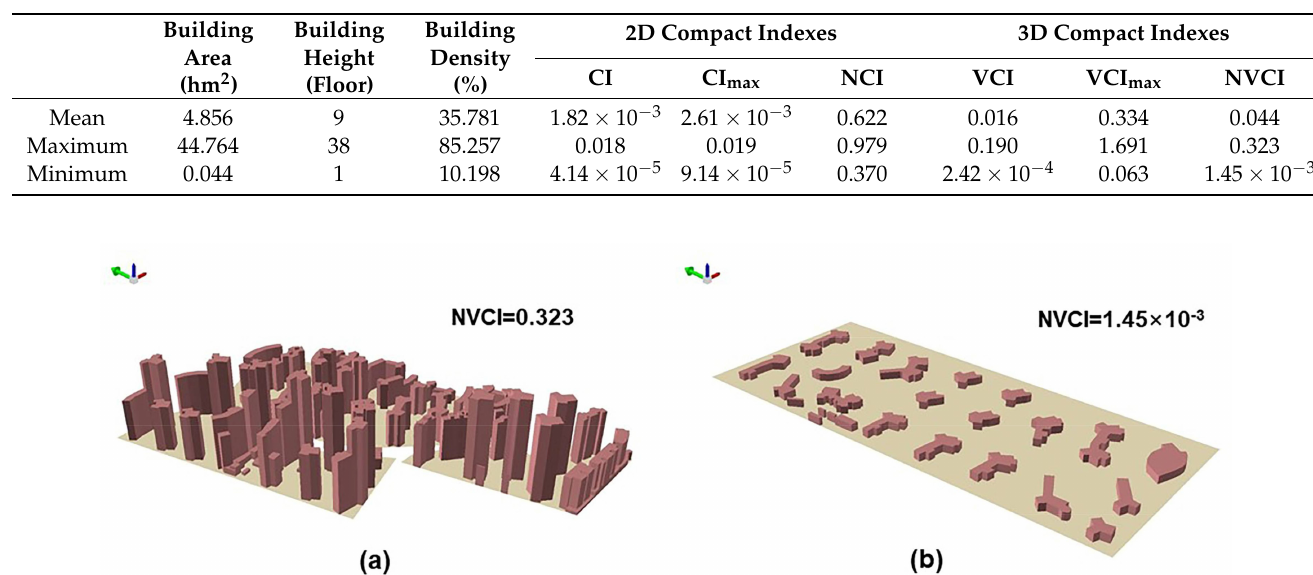
Table 2. Statistics of urban building characteristics.